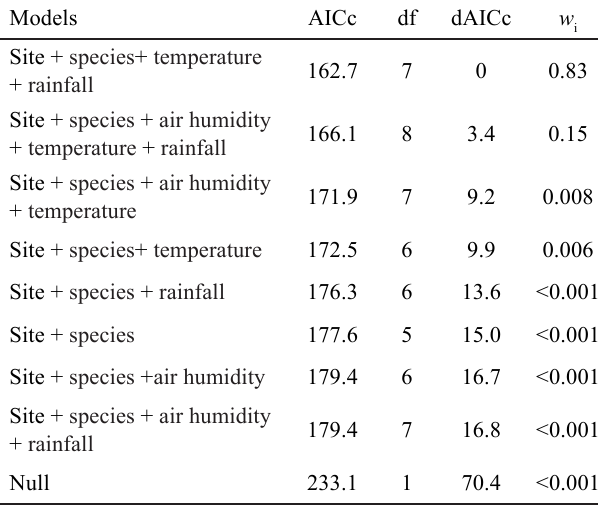
Table 4 . Summary of generalized linear models with Poisson distribution, which describe the relationship between number of occupied nests, temperature and precipitation, using the study site and bee genera as covariates. The models are classified in ascending order of AIC values. C